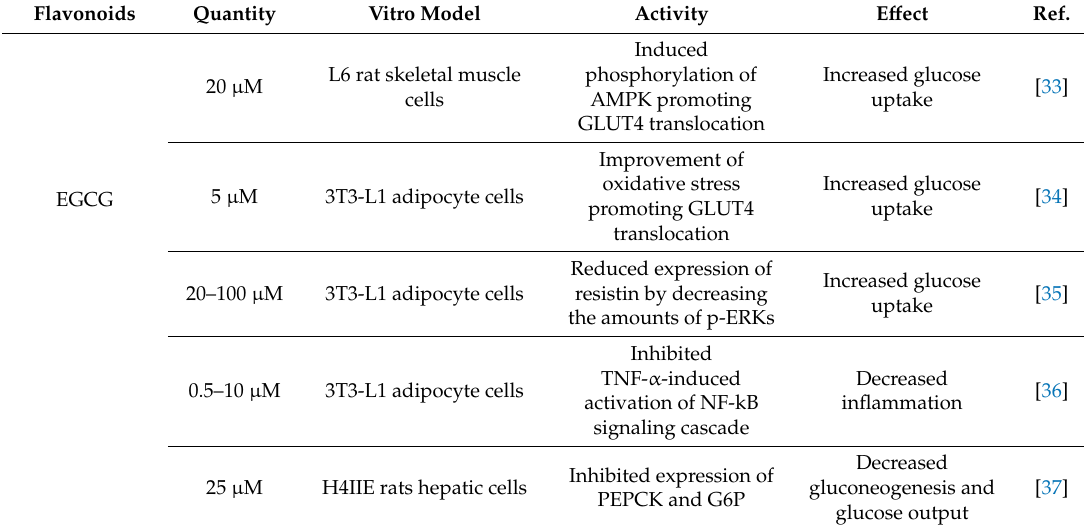
Table 3. E ff ects of flavonoids on insulin sensitivity in in vitro